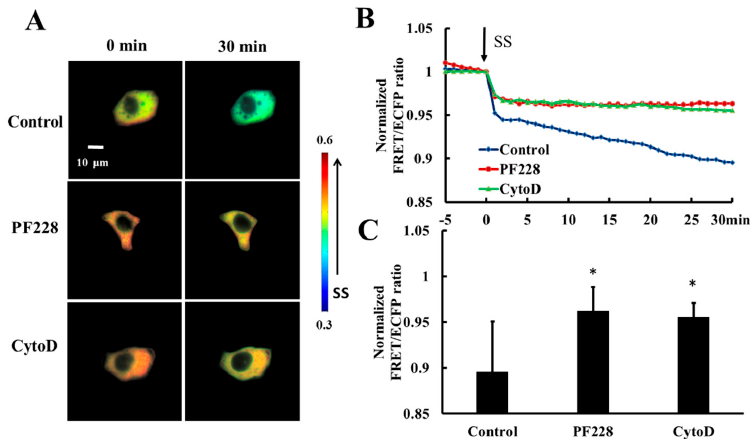
Figure 6. Effect of FAK activation and actin accumulation on shear-stress-induced HSP27 depolymerization. ( A ) The FRET ratio images of HSP27 under 20 dyn/cm 2 of shear stress after pretreatment of 50 nM PF228 or 1 μ M CytoD. ( B ) The line graph of HSP27 FRET ratio in the control,